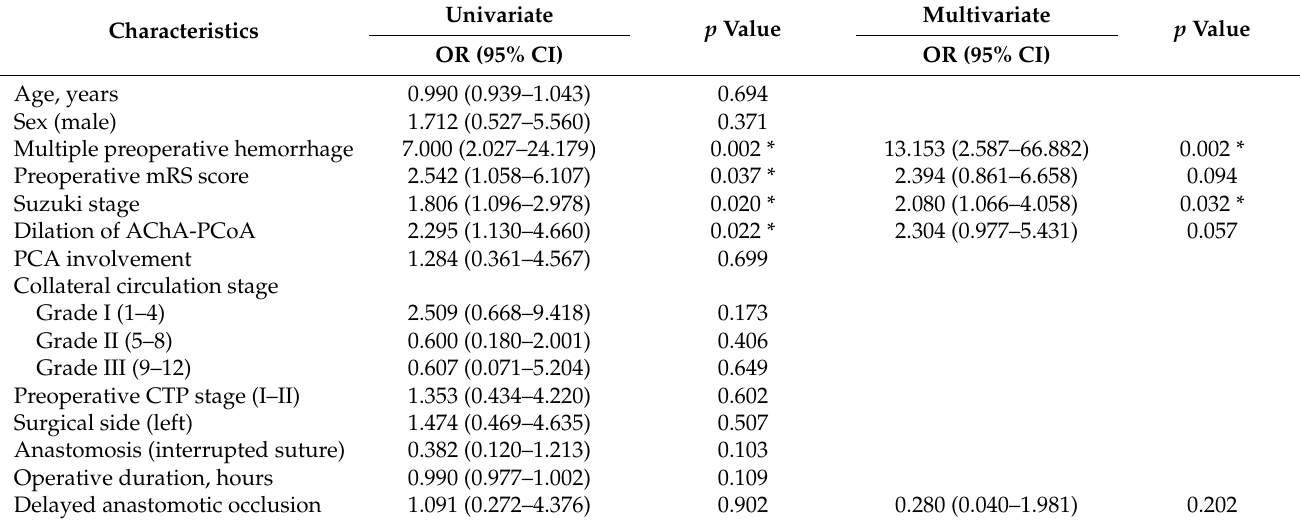
Table 3. Predictors of unfavorable outcomes (mRS > 2) in hemorrhagic moyamoya disease.